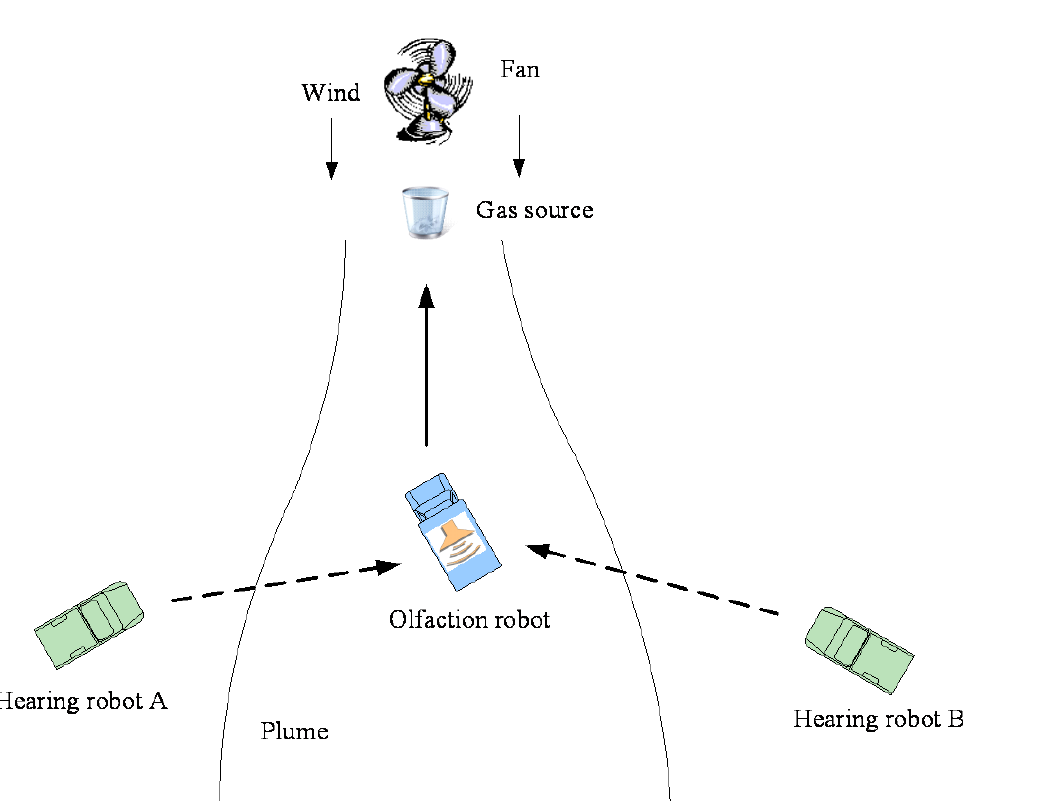
Figure 1. Schematic diagram of multi-robot